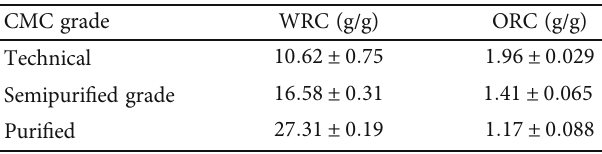
Table 4: Water retention capacity and oil retention capacity of di ff erent grades of CMC.